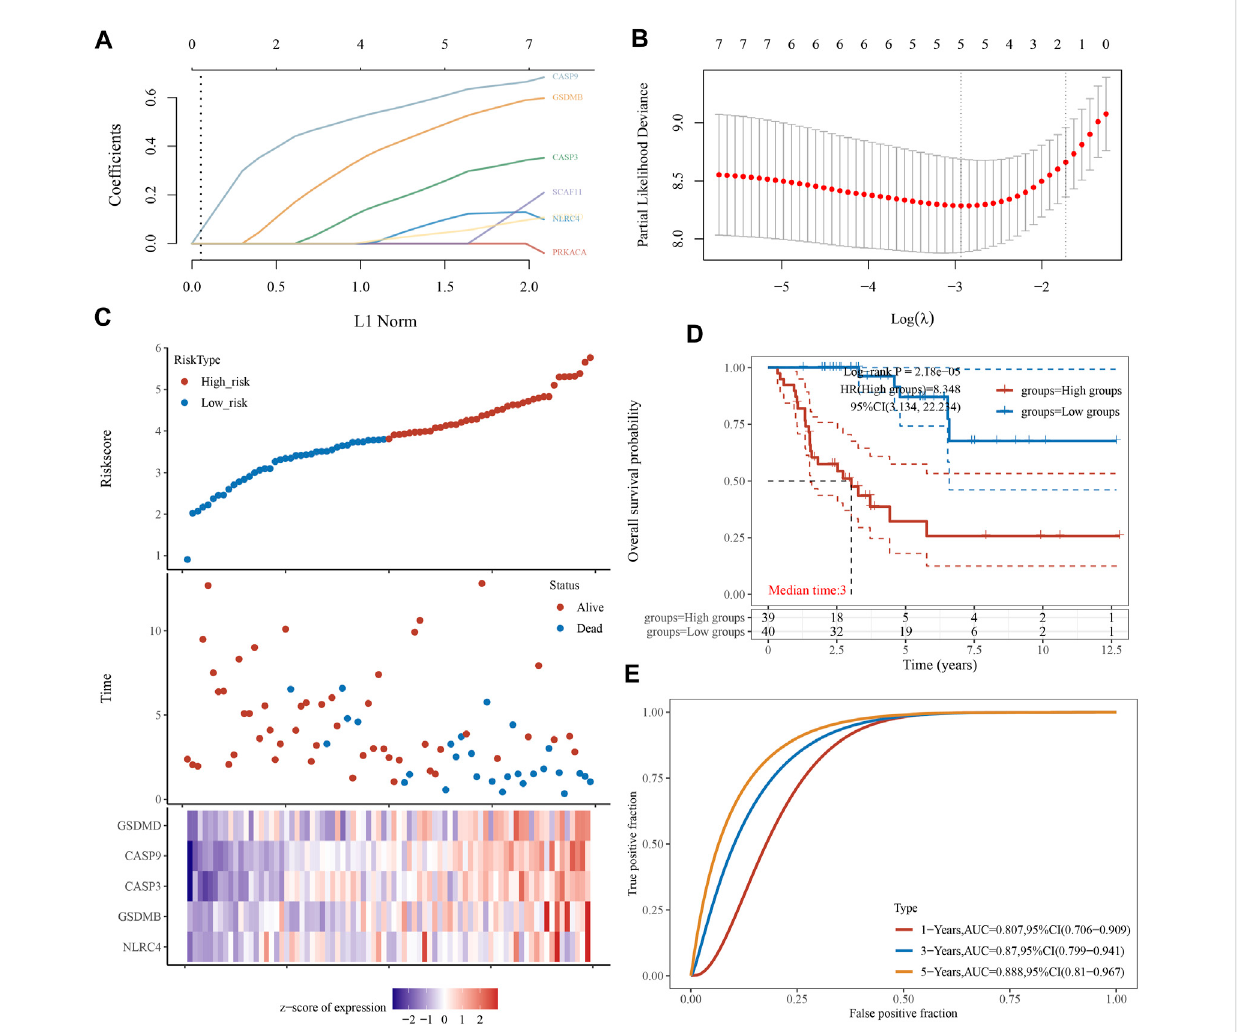
FIGURE 5 Construction of a prognosticPRGs model. (A) LASSO coef fi cient pro fi les of the seven PRGs. (B) Plots of the ten-fold cross-validation error rates. (C) Distribution of risk score, survival status, and the expression of fi ve prognostic PRGs in ACC. (D, E) Overall survival curves for ACC patients in the high-/ low-risk group and the ROC curve for measuring the predictive